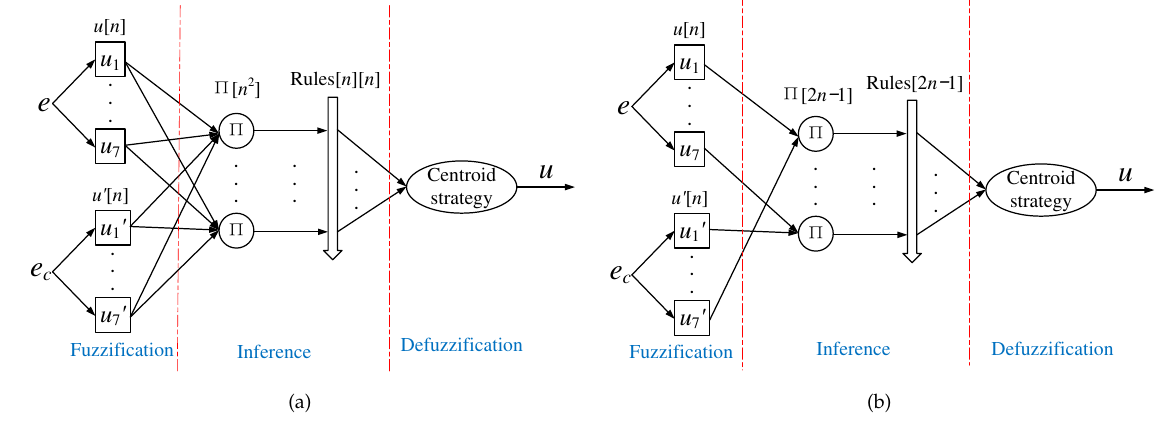
Figure 12. Structures of FPID and S-FPID: ( a ) FPID structure, ( b ) S-FPID